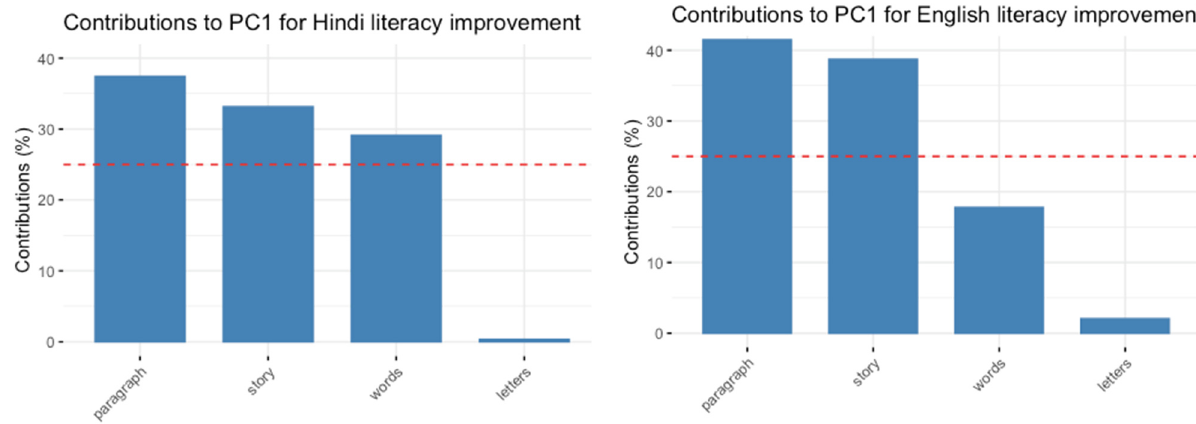
Figure A4. Contribution of variable to each of the first principal components for the literacy data.